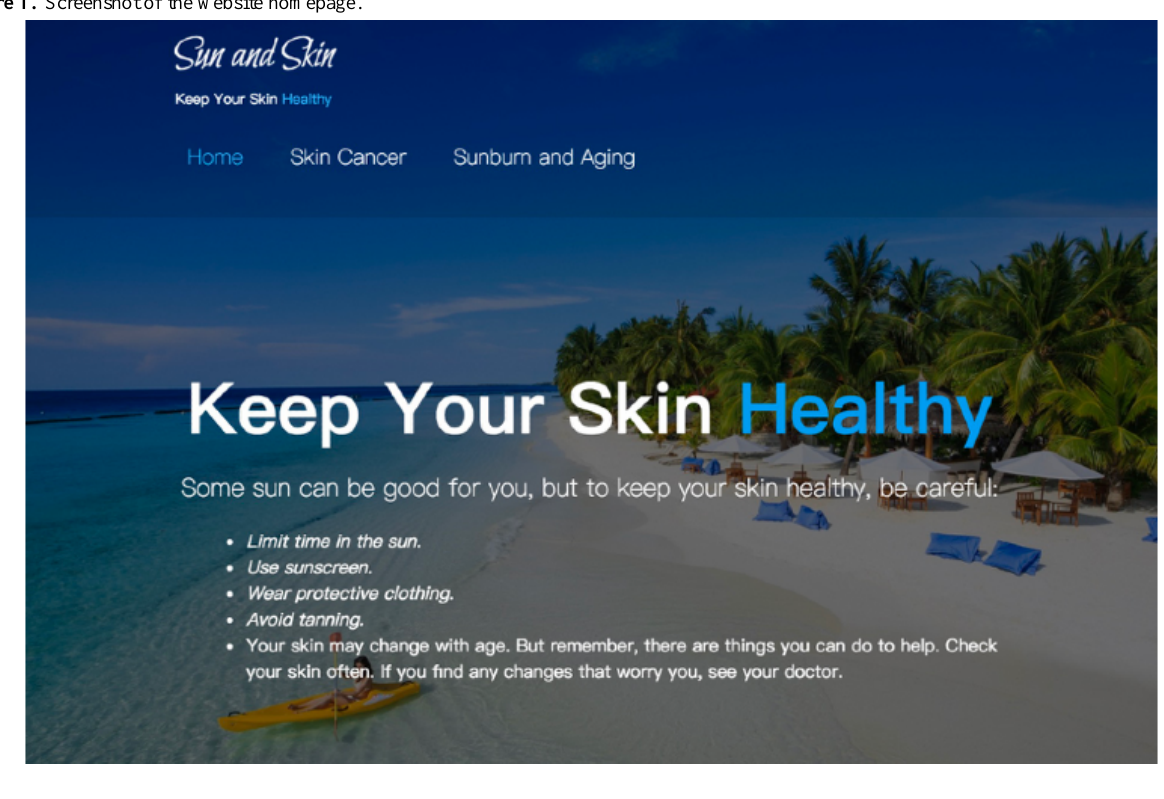
Figure 1. Screenshot of the website homepage.